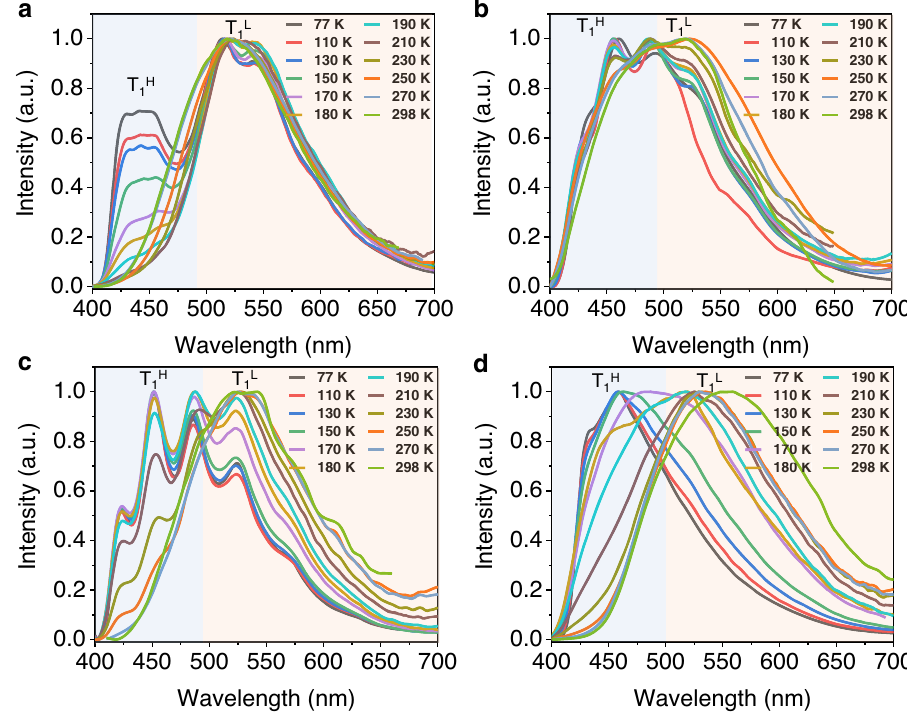
Fig. 5 Temperature-dependent time-resolved emissions of PMMA fi lms for showing dual phosphorescence. Normalized phosphorescence emission spectra of TPA2 ( a ), TPA3 ( b ), TPA4 ( c ), and TPA5 ( d ) dissolved in PMMA fi lm ( Δ t = 1 ms; excitation: 375 nm; and concentration: 3%, w/w) at different temperatures showing the two triplet-state